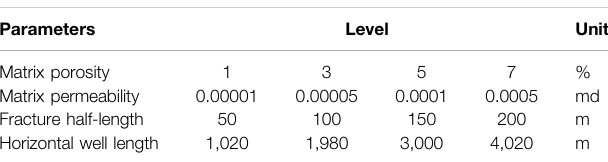
TABLE 2 | The levels of four